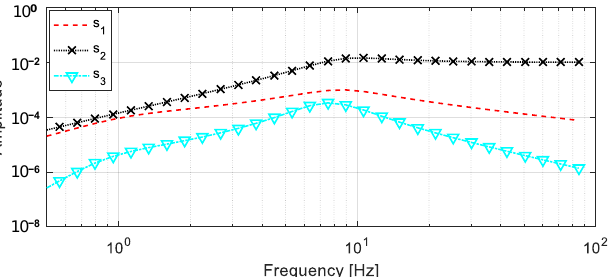
Figure 4. Amplitudes of the acceleration frequency responses of the vehicle at the measurement points to the unit impulse applied on the rear wheel along degrees of freedom (DOF) u 3 .